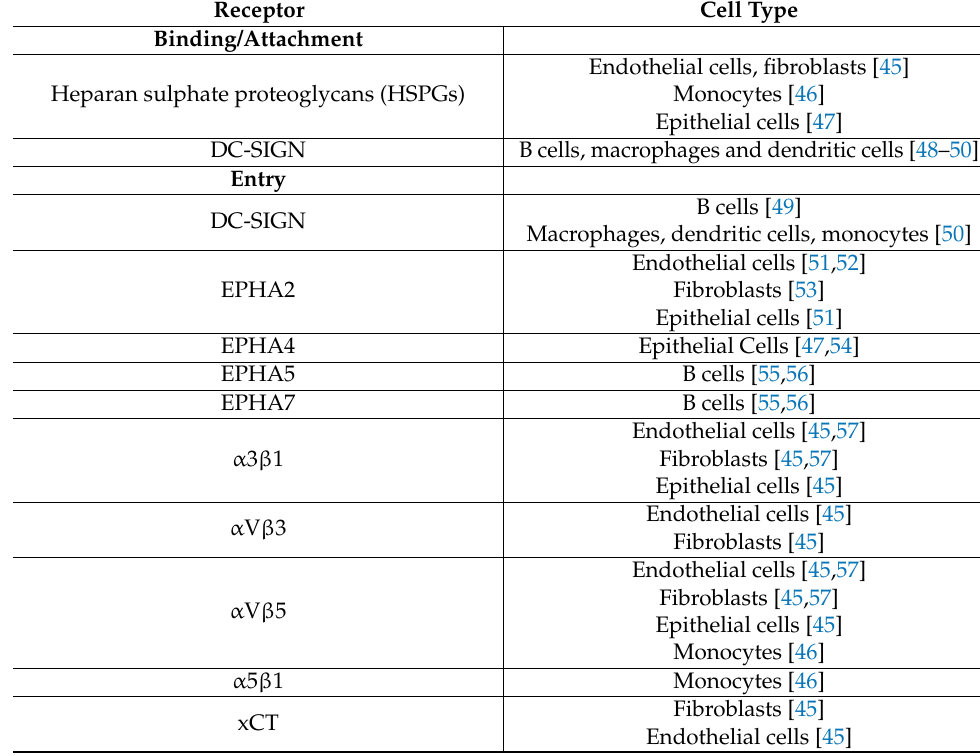
Table 1. Summary of the known KSHV receptors on susceptible cell